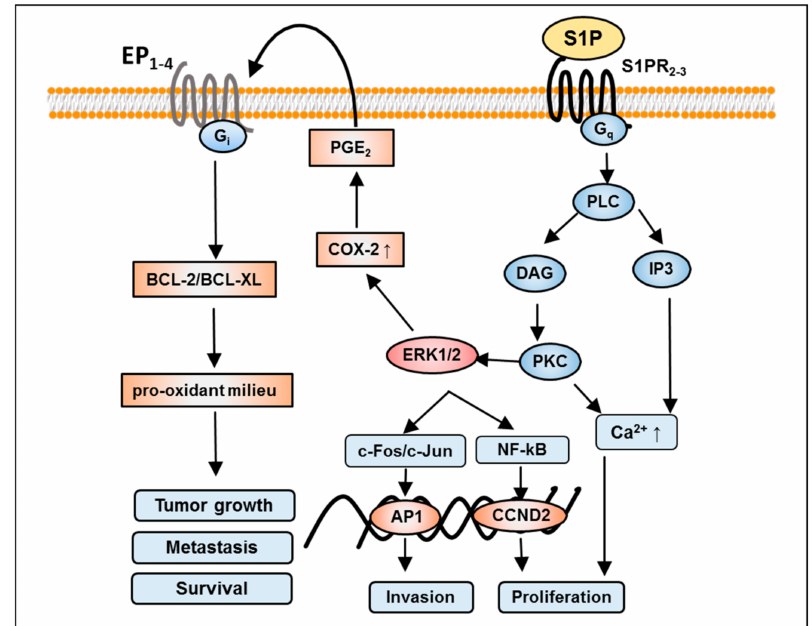
Figure 4. Illustrative scheme of Gq-protein (Gq)-mediated S1P effects in glioblastoma. Activation of S1PR2 and S1PR3 through stimulation of Gq-subunit boosts calcium mobilization and PLC/PKC/ERK1/2 signaling. Following either pathway increases invasion and proliferation by activation of transcription factor activating protein 1 (AP1) and NF-kB-mediated CCND2 expression, respectively. Conversely, S1P also induces cyclo-oxygenase 2 (COX-2) expression and therefore prostaglandin E2 (PGE2) production, in turn, transactivates prostaglandin receptors (EP1-4) receptors leading to a Gi-dependent intracellular signaling mechanism (e.g. activation of the BCL-2/BCL-XL family members). Subsequently, this cascade upturns oxidative stress which is responsible for the transformation of a normal cell to tumor cell, its metastasis and thus survival. Additional abbreviations used in the figure are defined as follows: BCL2; B-cell lymphoma 2; BCL-XL, B-cell lymphoma-extra-large; Gi, Gi-protein; ↑ ,